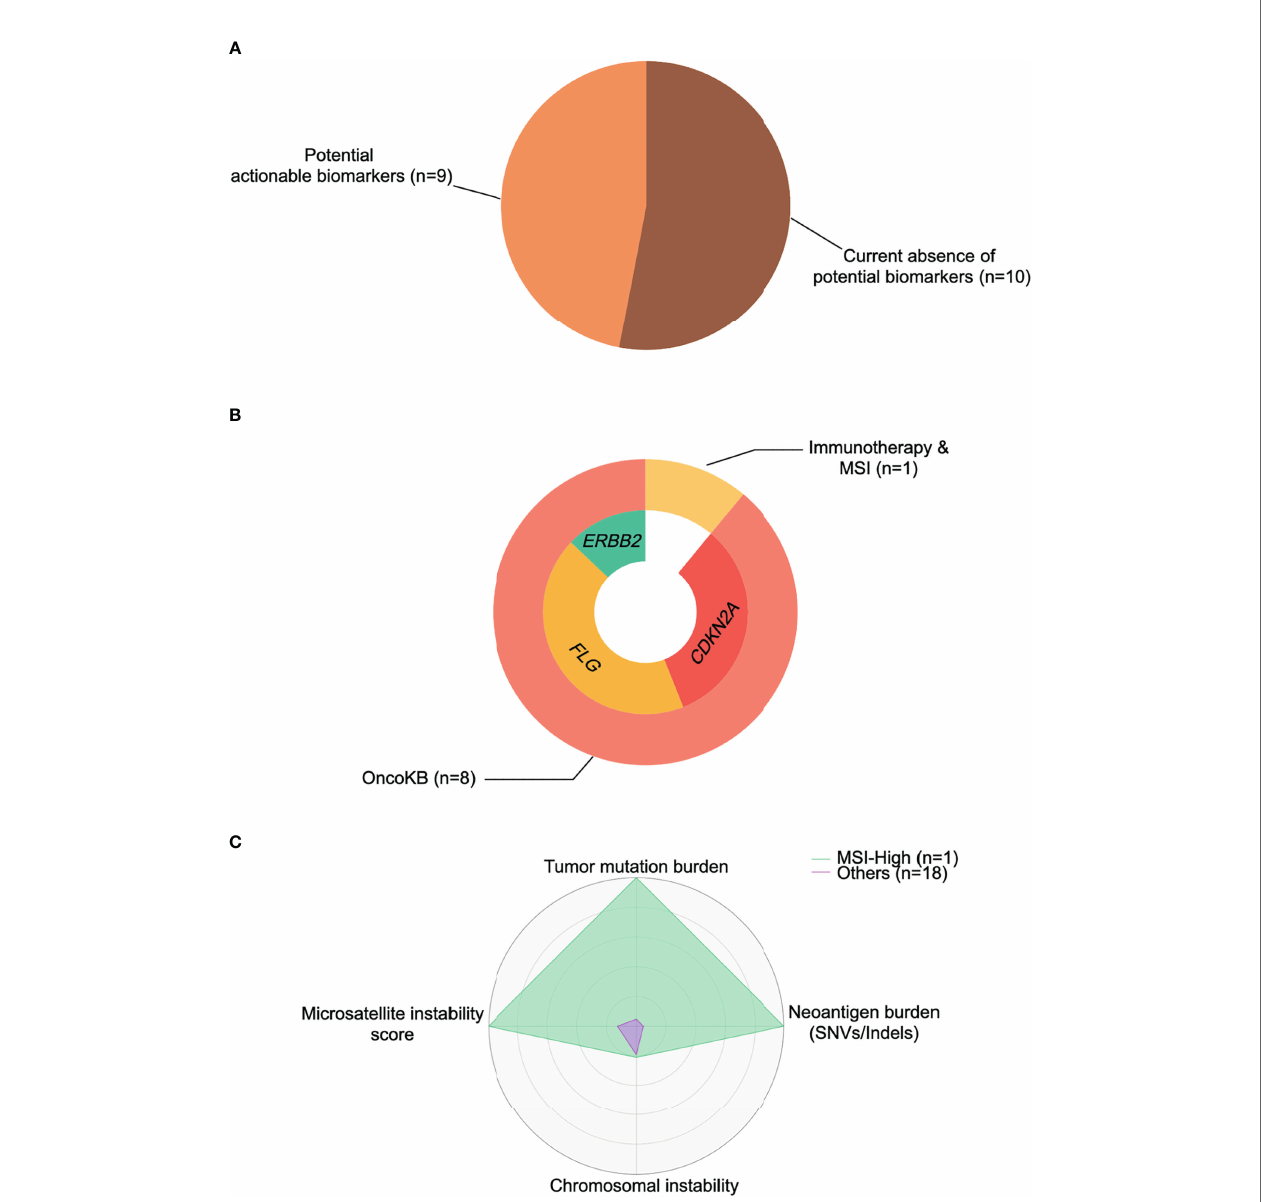
FIGURE 5 | Cancer-immune interactions for actionable biomarkers in thymic carcinoma. (A) Percentage of patients with actionable biomarkers for treatment. (B) Percentage of patients with microsatellite instability (MSI)-high status and actionable biomarkers ( ERBB2 , FLG , CDKN2A ) strati fi ed by immunotherapy based on OncoKB database (39). (C) The representative radar plot of cancer-immune interactions to identify the thymic cancer patient amenable to immunotherapy. SNV, single nucleotide